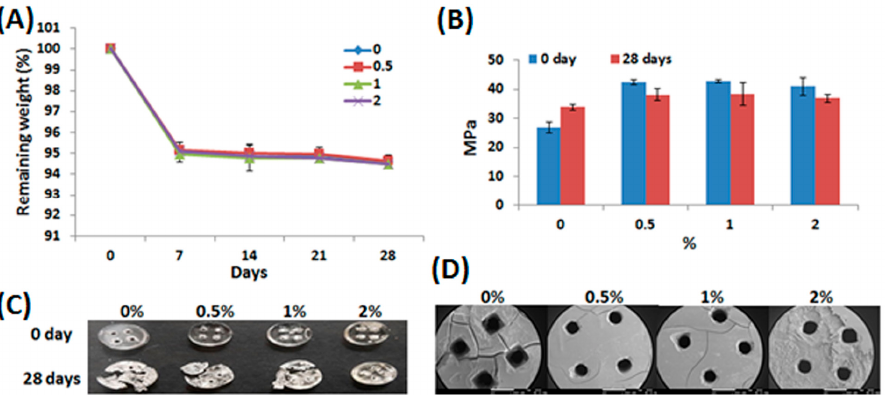
Figure 4. The mechanical properties and degradation rate of the PU/HA hybrid scaffolds. ( A ) The degradation profile of the PU/HA hybrid scaffolds with different HA concentration, expressed as percent remaining weight; The ( B ) Young’s modulus and ( C ) images of the PU/HA hybrid scaffolds after compressing tests for 0- and 28-day degradation tests; ( D ) The SEM images of the PU/HA hybrid scaffolds after 28-day degradation tests. The scale bar is 1 mm.